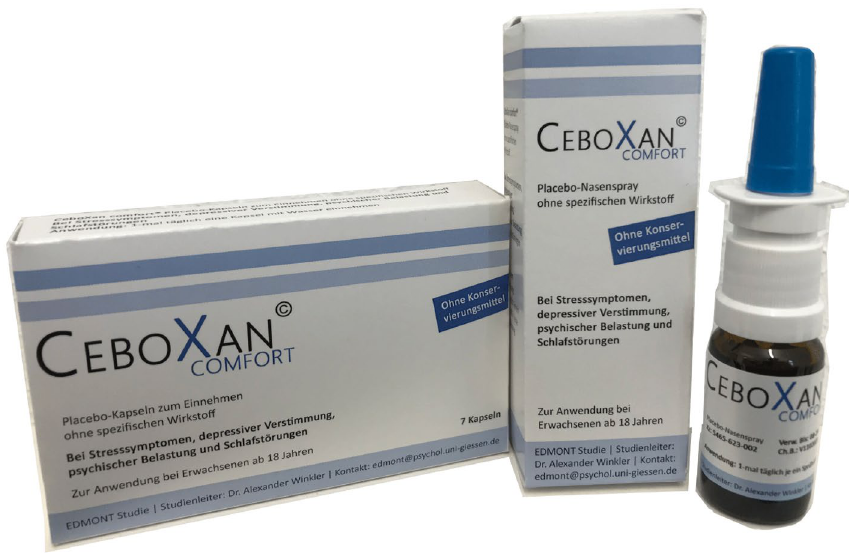
Figure 2. CeboXan Comfort OLP capsules and nasal spray presented as placebo without active ingredient for the treatment of psychological